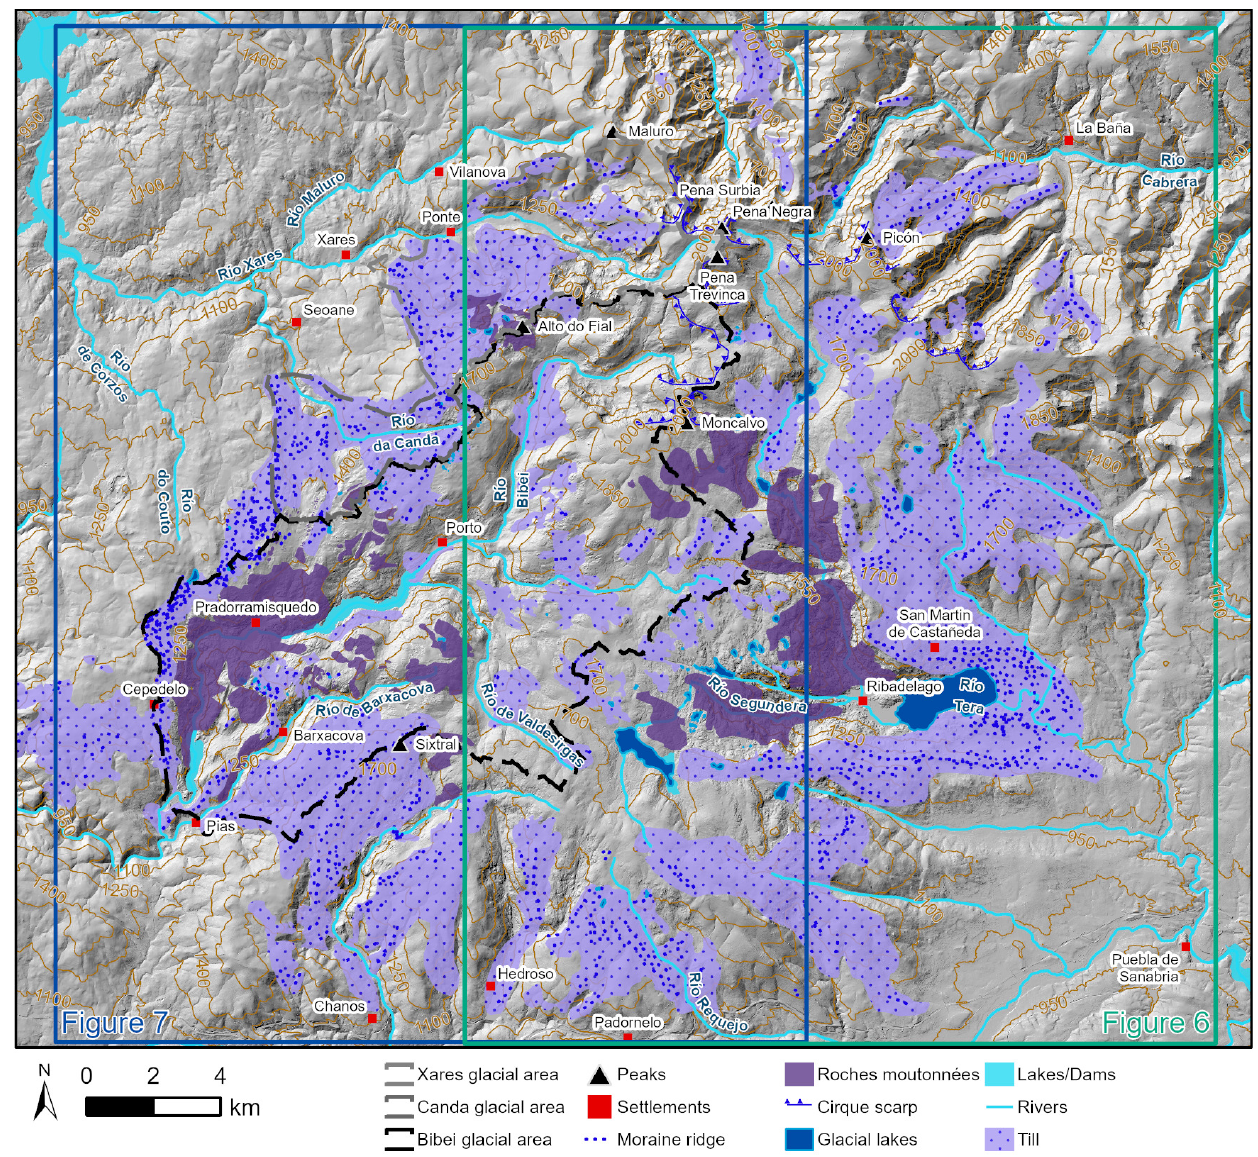
Figure 5. Map about glacial landforms and analyzed paleobasins at the Trevinca Massif. Location in Figure